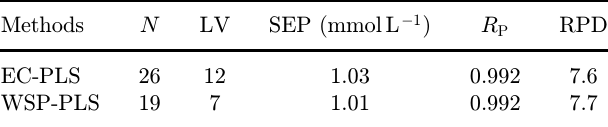
Table 3. Prediction e®ects of the optimal EC-PLS and WSP- PLS models in validation.